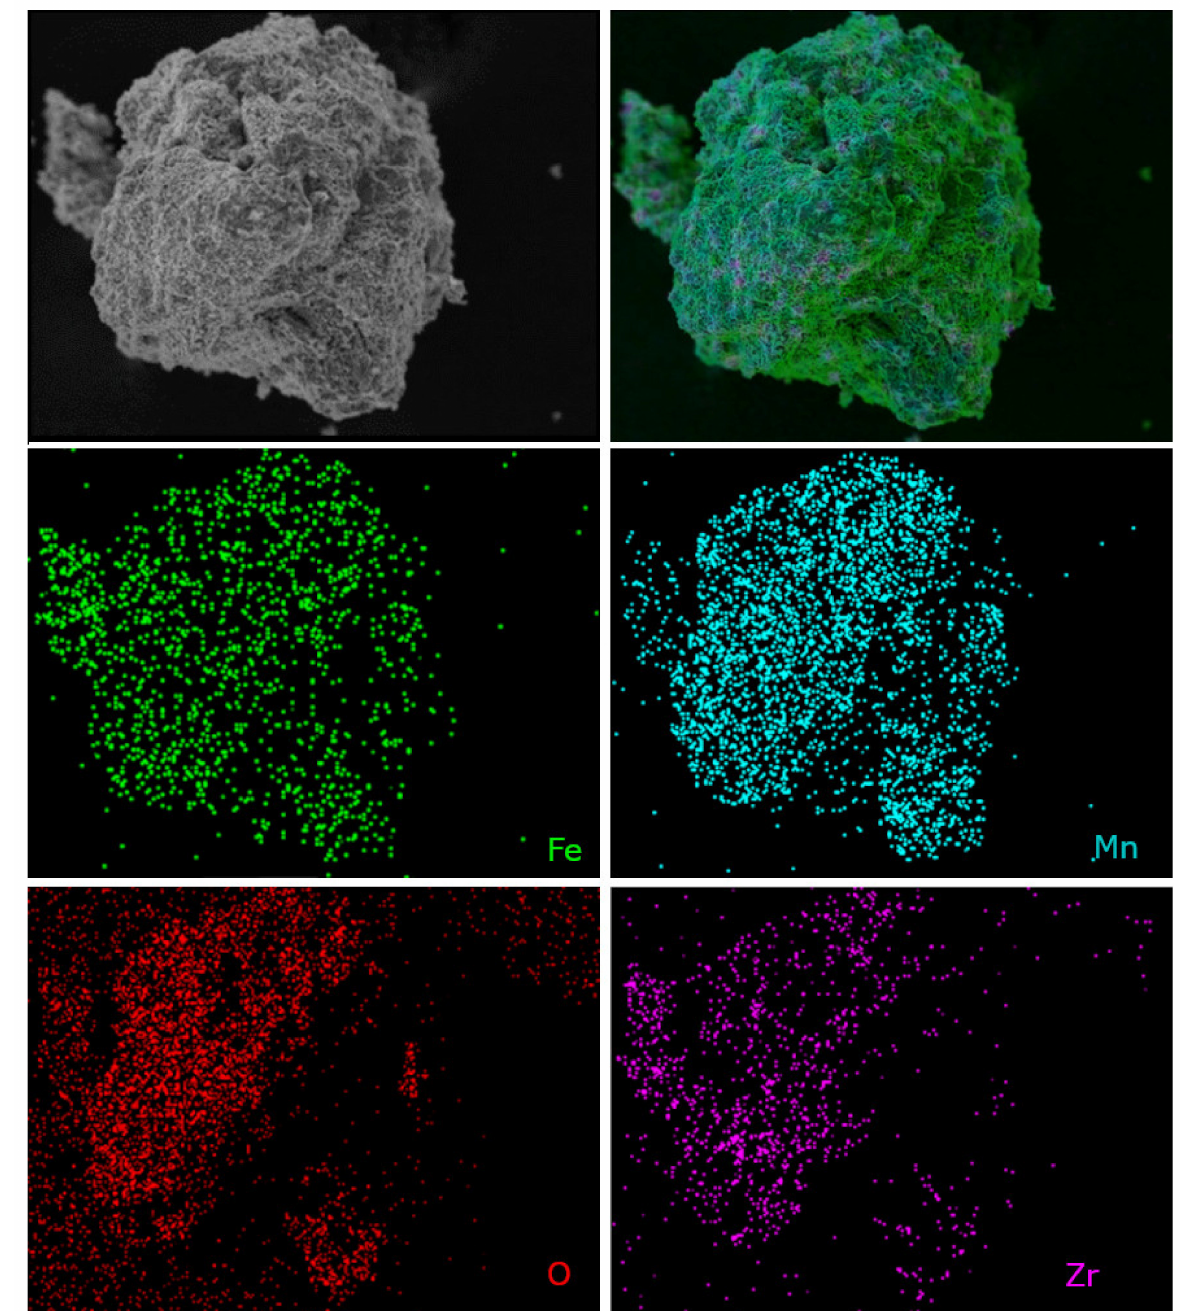
Figure 9. Scanning electron microscope photomicrographs with element mapping for fresh F50Mn30Zr20 sample. The XRD analyses of spent oxygen carriers (Figure 2) showed that their crystal struc- tures have not changed significantly after cycling reactions carried out under high tem- perature (800–1000 ◦ C) for about 25 h of experiments. However, profound phase analysis showed some minor crystal phase changes in the diffractograms during cyclic fuel combus- tion carried out at high